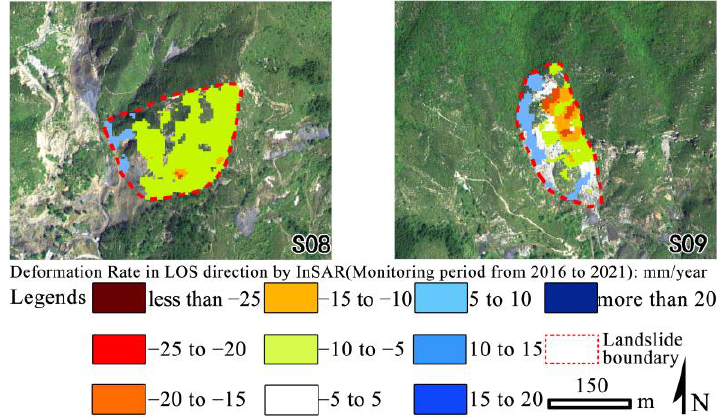
Figure 10. InSAR time series results of landslide S08 and S09.